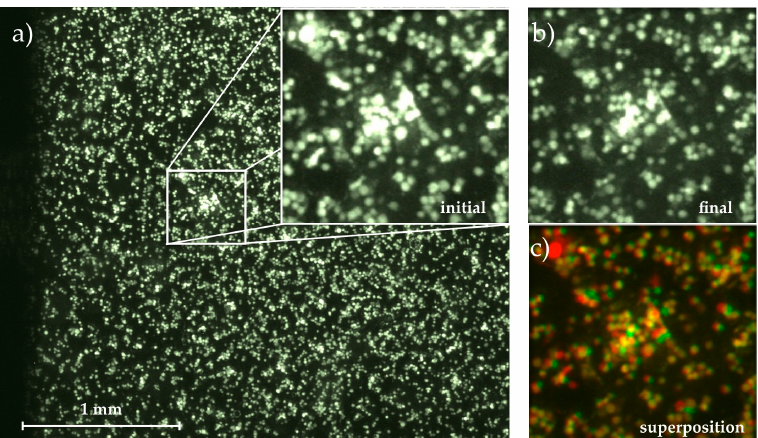
Figure 2. Micrograph of the adhered cells on the substrate with magnification of ( a ) initial state at t 0 = 0 min; and ( b ) final state at t = 60 min; ( c ) Superposition of both images using the